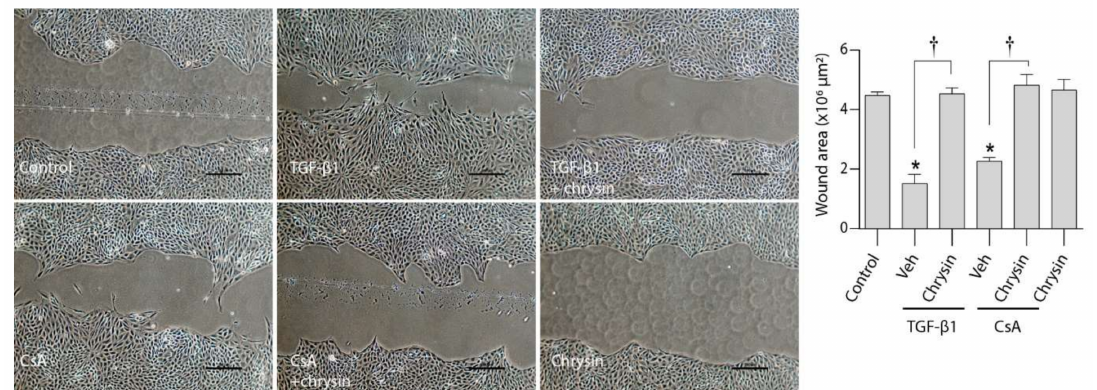
Figure 5. Effect of chrysin on CsA- or TGF- β 1-induced EMT protein expression. LLC-PK1 cells were treated with vehicle (Veh), 4.2 µ M CsA, 5 ng/mL TGF- β 1 or 25 µ M chrysin (Chr) or both for 48 h. ( A ) Protein expression of epithelial and mesenchymal markers were assayed using the Western blot method. Representative Western blots for E-cadherin, α SMA and vimentin are shown, and data are represented as mean intensity relative to β -actin ± SD of three individual experiments. ( B ) The amount of collagen deposited in the cell monolayers was assayed by Sircol™ Sirius red assay and normalized to protein content. Data are represented as mean collagen content ± SEM of four individual experiments. Statistical significance was determined by one-way ANOVA followed by Tukey’s multiple comparison test. * indicates p < 0.05 versus control; † indicates p < 0.05 versus chrysin co-treatment.